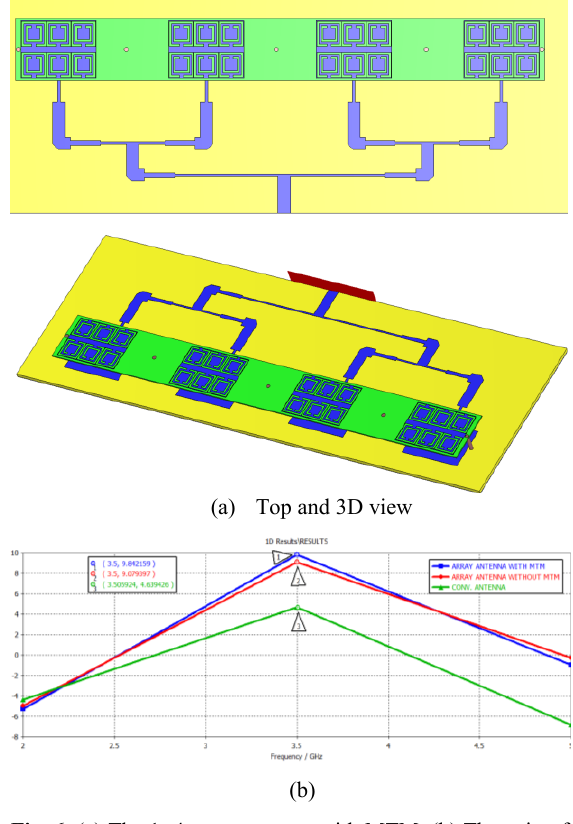
Fig. 6. (a) The 1×4 antenna array with MTM, (b) The gain of a single basic radiating element, the gain of an antenna array without MTM, and with MTM